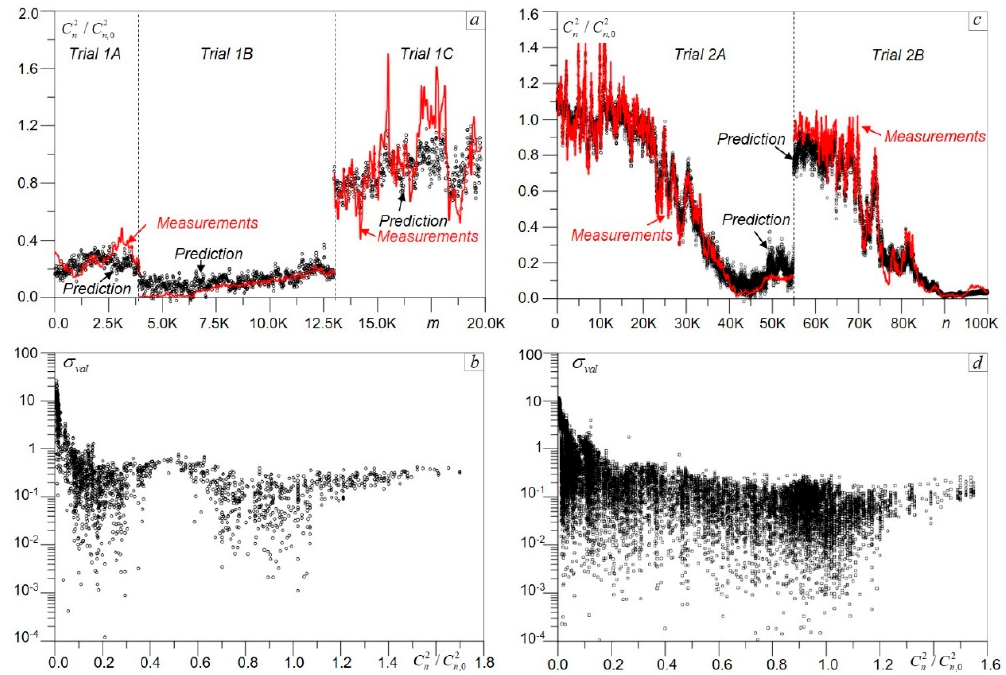
C prediction with deep machine learning performed for ATM#1-V Figure 7. Results of the C 2 n prediction with deep machine learning performed for ATM#1-V (validation) Figure 7. Results of the 2 n ( a , b ) and ATM#2-V ( c , d ) datasets using preliminary trained Cnˆ2Net models ( N model = 20). The plots ( a ) (validation) ( a , b ) and ATM#2-V ( c , d ) datasets using preliminary trained Cn^2Net models ( N model = 20). and ( c ) compare measured (solid lines) and predicted (dots) C 2 n values dependent on the frame stamp C The plots ( a ) and ( c ) compare measured (solid lines) and predicted (dots) 2 n number m in the corresponding datasets. The scatter plots in ( b , d ) characterize the standard deviation of prediction error for the entire range of C 2 n values in the corresponding ATM datasets ( c 2 n = C 2 n / C 2 n ,0 = 1 · 10 − 14 m − 2/3 and C 2 n ,0